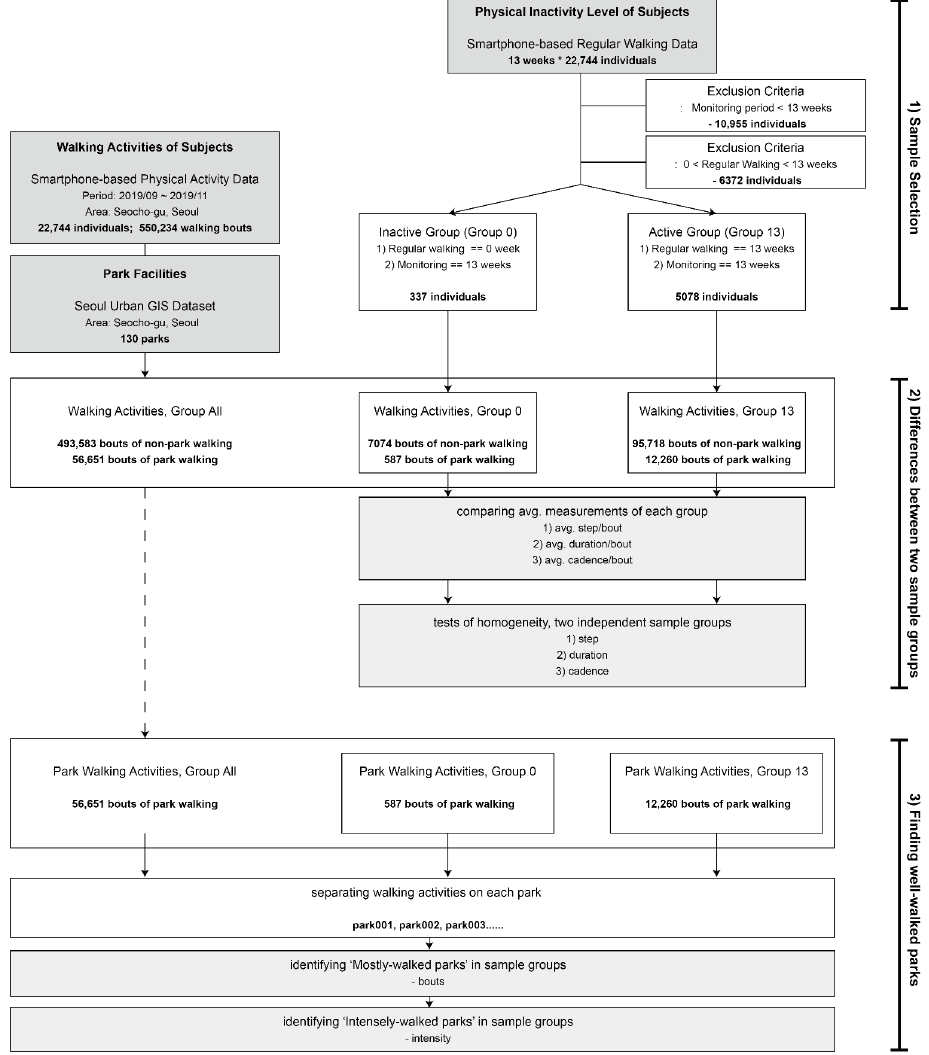
Figure 2. Research Figure 2. Research Design . 3.1. Sample Selection: Classifying the Physically Inactive and Active Groups